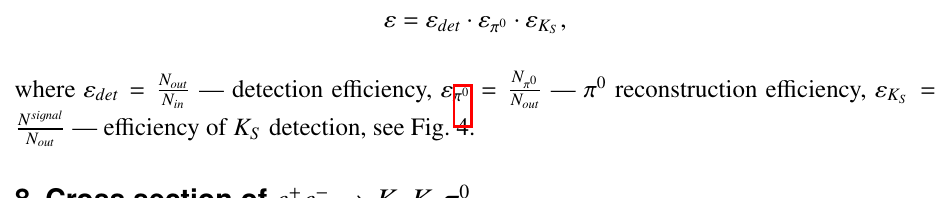
Figure 4. Dependence of the ef- ficiency on c.m. energy